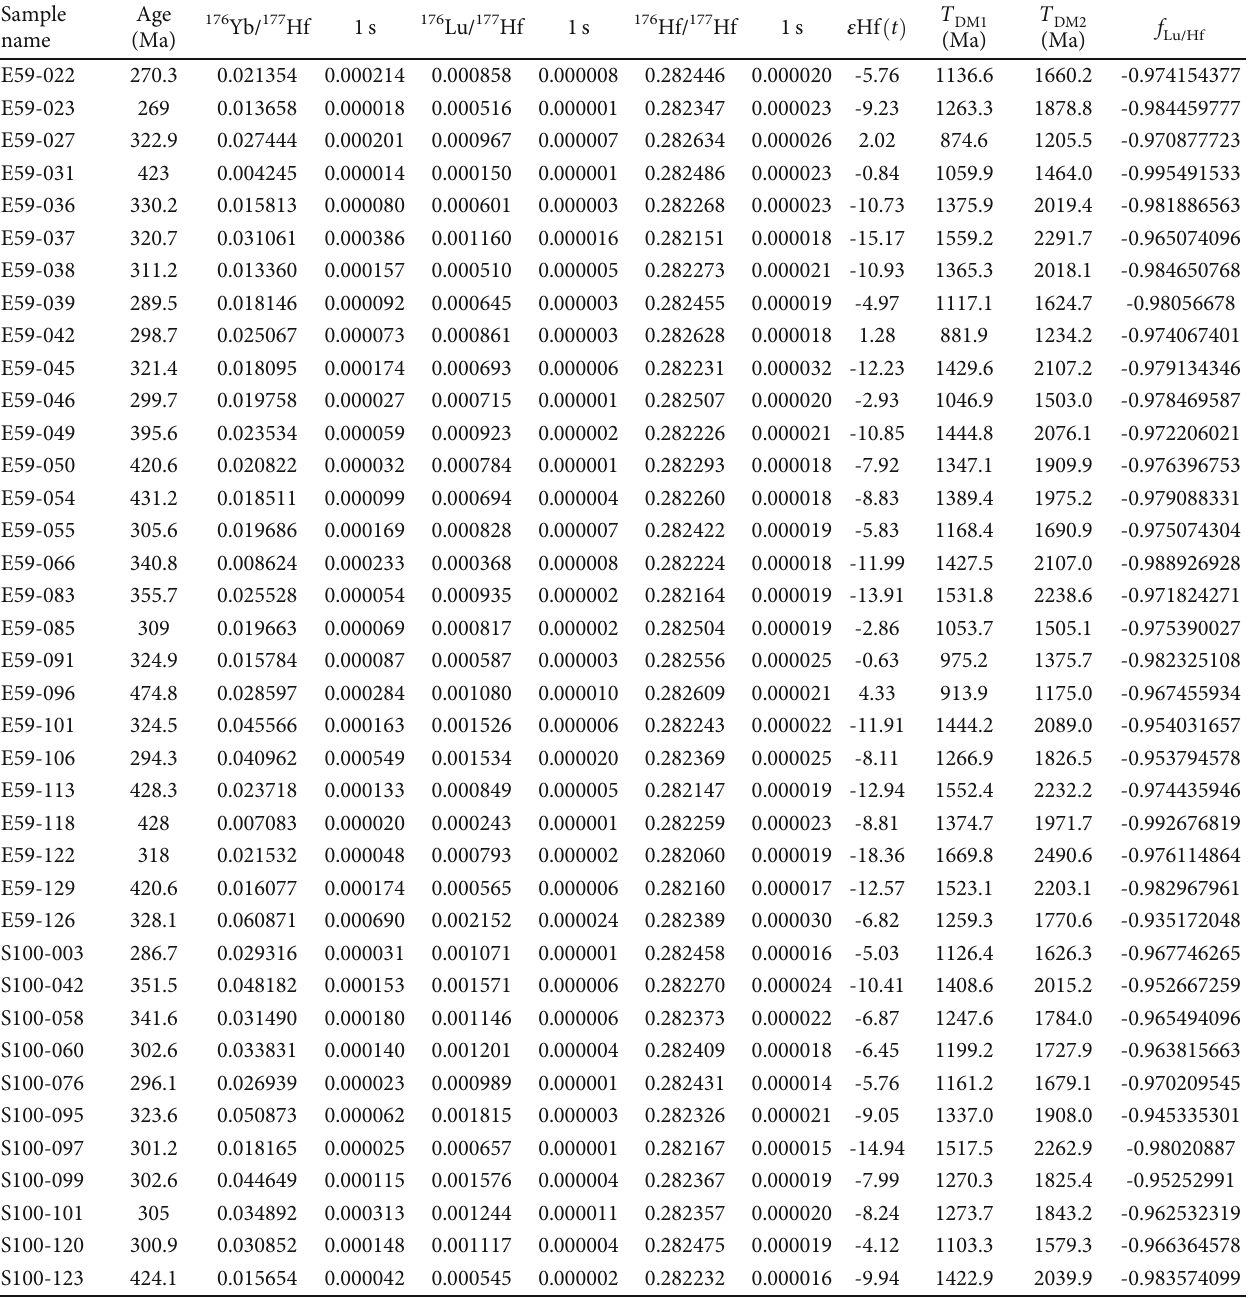
Table 2: Hf isotope analyses of zircons for the samples of the study